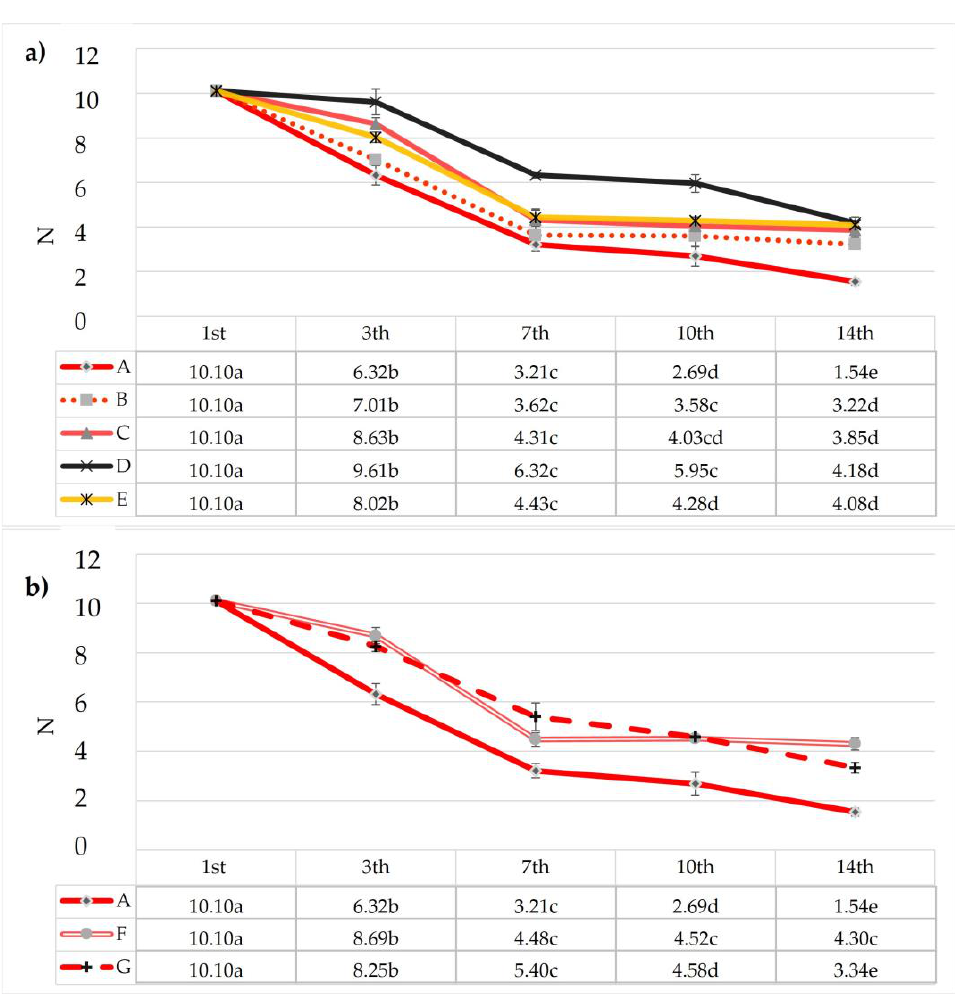
Figure 4. Effects of edible coatings enriched with AE ( a ) and BEO ( b ) on the firmness of strawberries during storage. Small letters within a column show a significant difference as assessed by Tukey’s post hoc